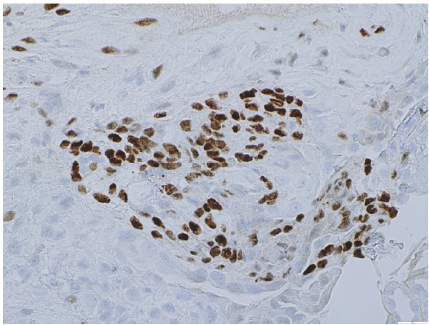
Figure 3: Glandular cells showing nuclear positivity with immuno- histochemical